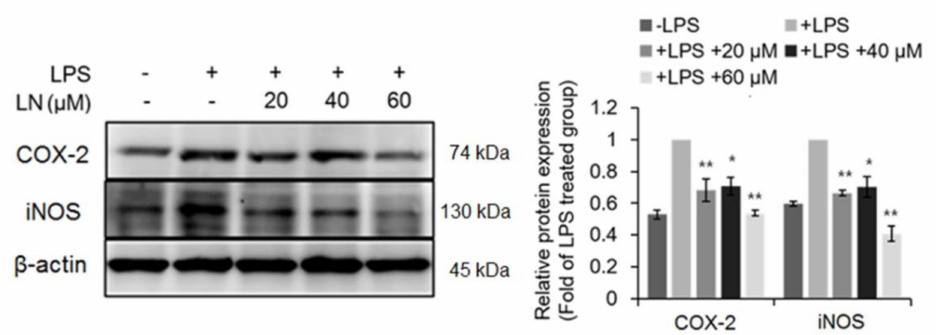
Figure 4. Lutonarin reversed the LPS-induced upregulation of anti-inflammatory enzymes COX-2 and iNOS. RAW 264.7 cells were incubated with the indicated concentration of lutonarin (LN) for 4 h, and then treated with 1 µ g/mL LPS for 24 h. Proteins were extracted, separated by SDS-PAGE, and quantified by Western blotting. Representative image of data is shown. A graph illustrates the density of the bands as compared with that of cells treated with LPS-only group. Data were from the three independent experiments and analyzed by ANOVA (* p < 0.05 and ** p < 0.01).